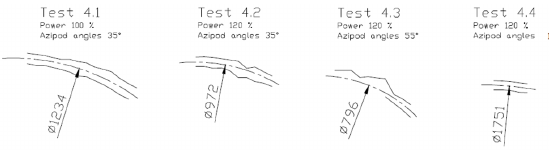
Figure 17: The measured tracks and estimated turn- ing diameters from the model tests (Source: Aker Arctic model test, Leivisk¨a (2011)). All numbers are at full scale (in meters).